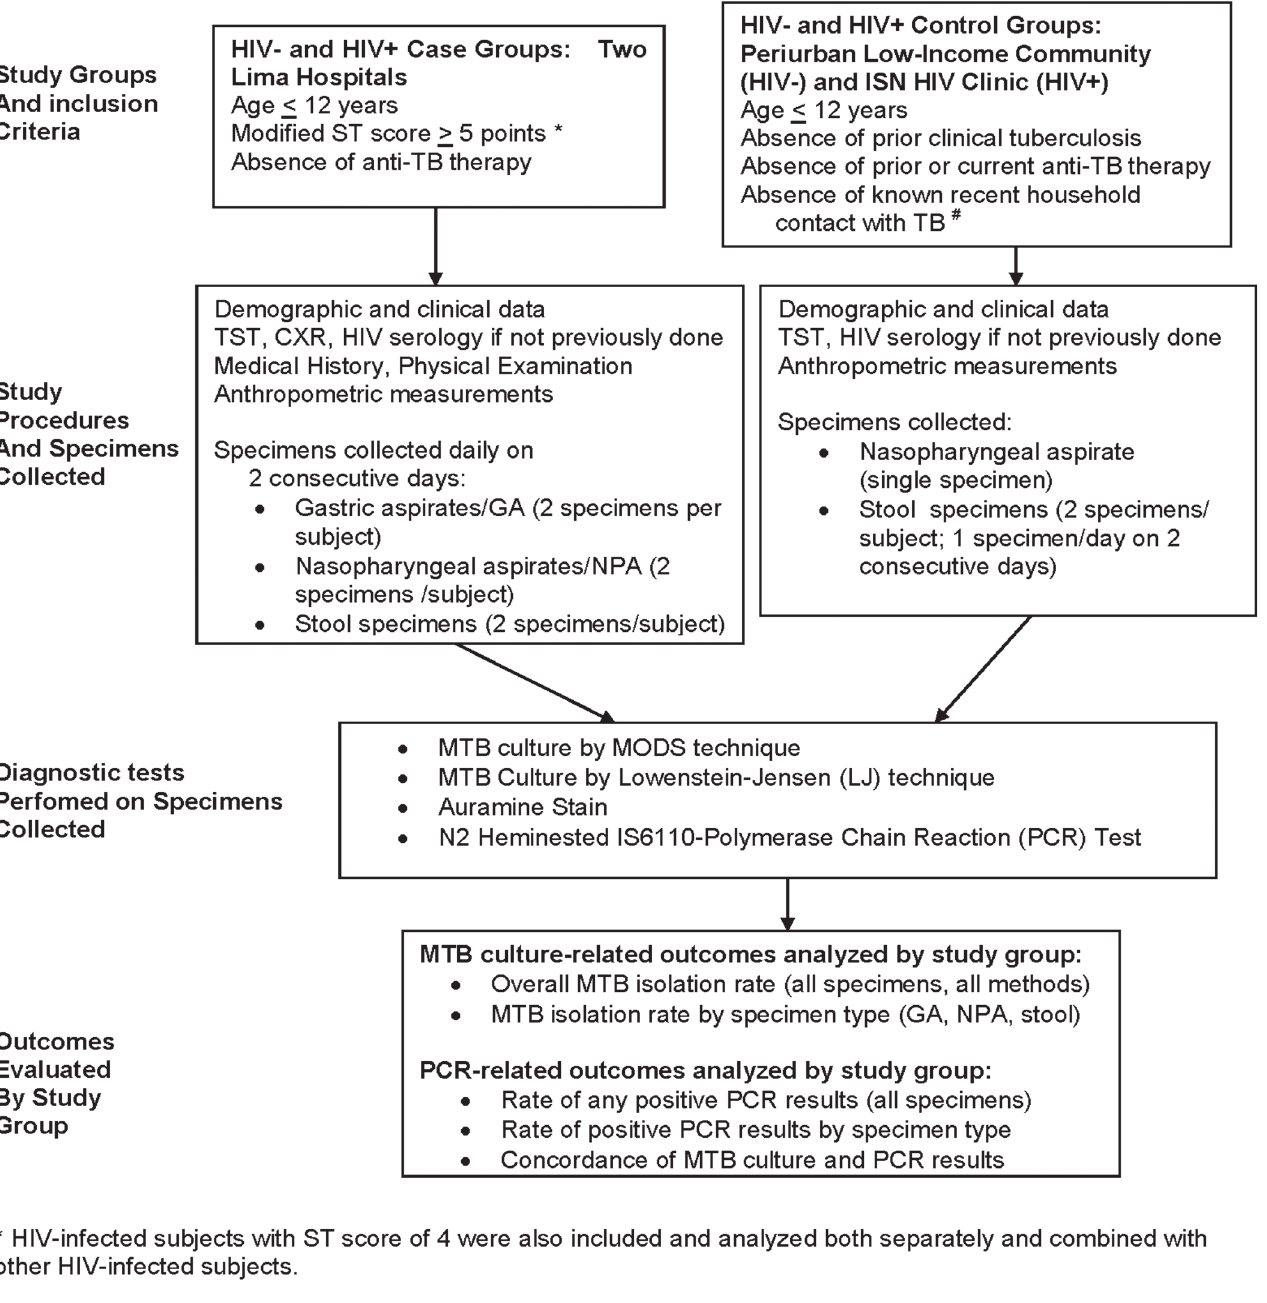
Fig 1. Study flow